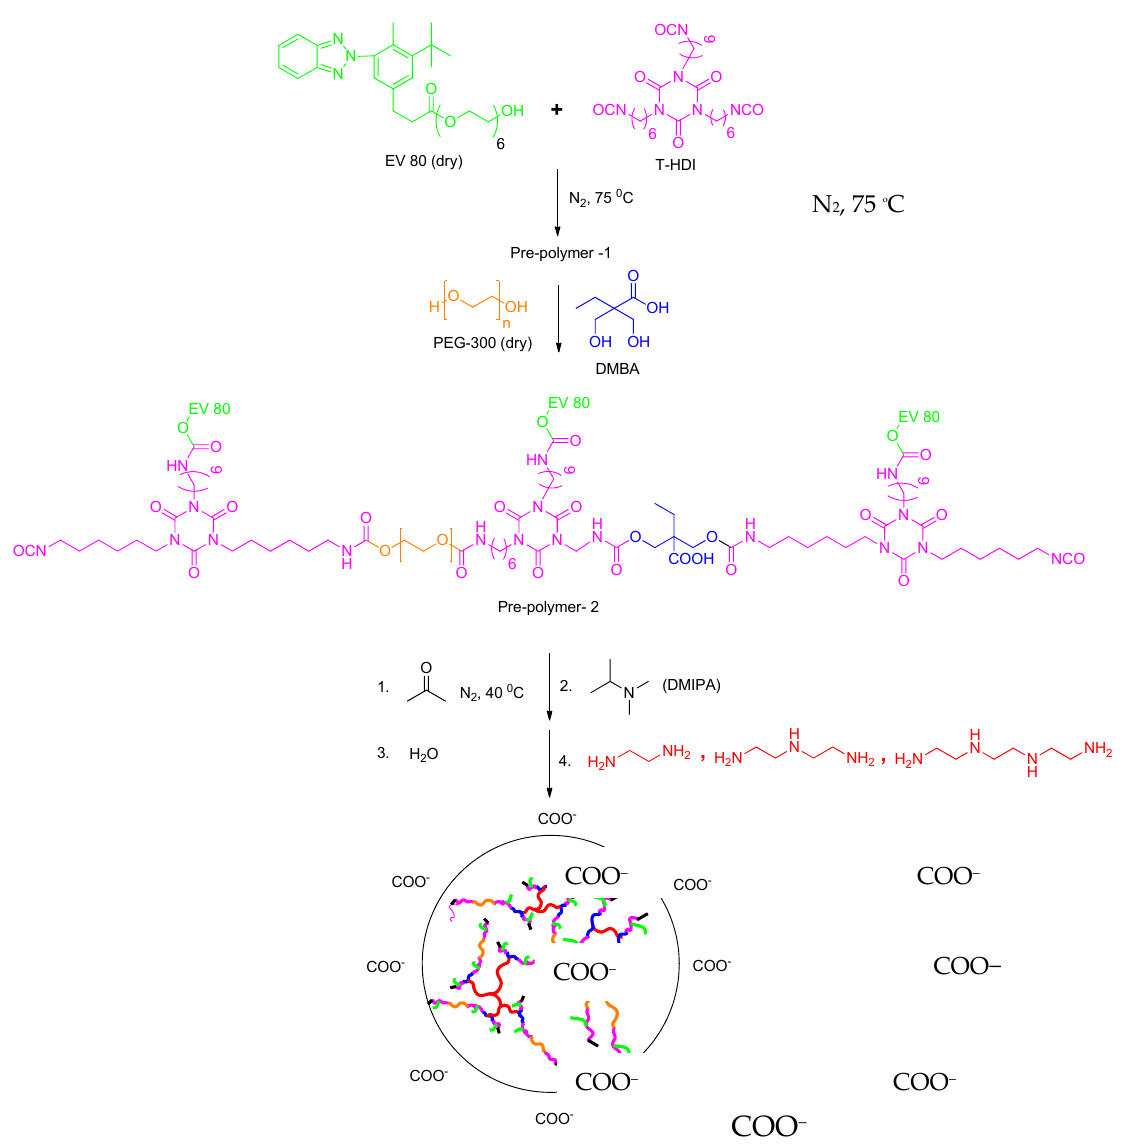
Figure 12. Synthetic route of WPU-g-BTA with side chain extenders.